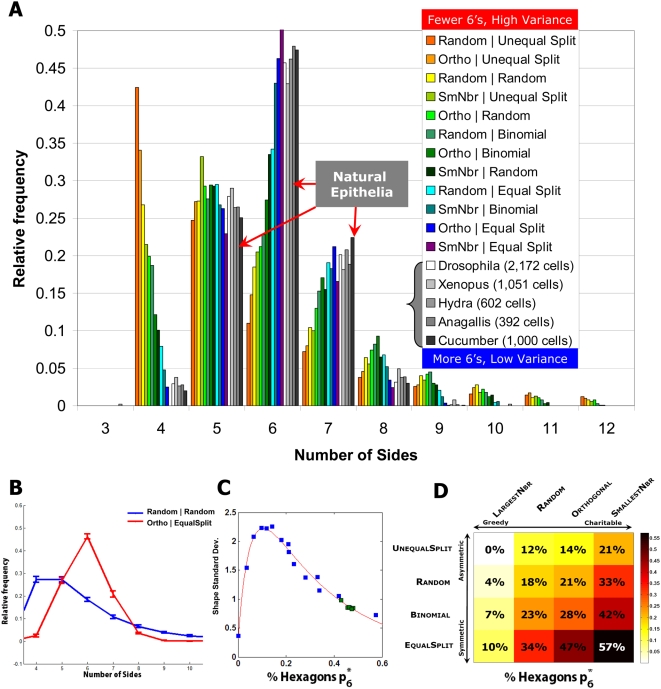
Convergence of proliferating epithelia to an equilibrium
distribution.(A) Steady-state shape distributions for all simulated CPMs (color),
sorted from high to low cell shape variance. Also included are the
proliferating epithelia (grayscale) from Figure 1; these epithelia have
lower variance than all but one simulated CPM
(SmallestNeighbor|EqualSplit). (B) Equilibrium cell shape
distributions for the stochastic Random|Random CPM
and the deterministic
Orthogonal|EqualSplit CPM with an initial
condition of a single cell with S0
sides, where S0 ranges from 4 to 250
sides. Probabilities are mean over all runs and error bars represent
range. (C) In the simulated CPMs, high hexagonal frequency is
strongly correlated with lower cell shape variability as measured by
standard deviation. Proliferating epithelia data (green) shows a
similar relationship between high hexagonal frequency and low shape
variability. (D) The fraction of hexagons in the equilibrium shape
distribution for all simulated CPMs. Rows and columns correspond to
the choice of first and second edge, respectively, and colors encode
the resulting fraction of hexagons after generation 12.